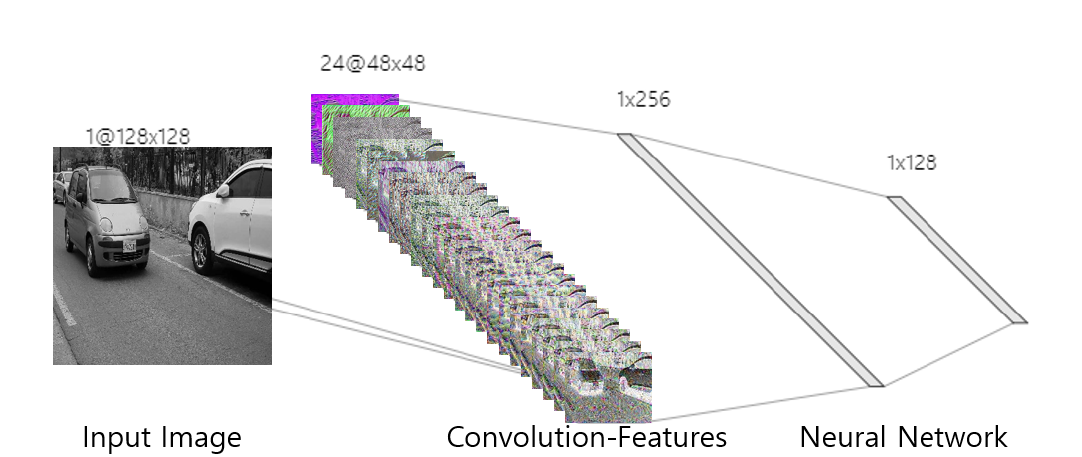
Figure 3. The convolutional neural network and convolution features.